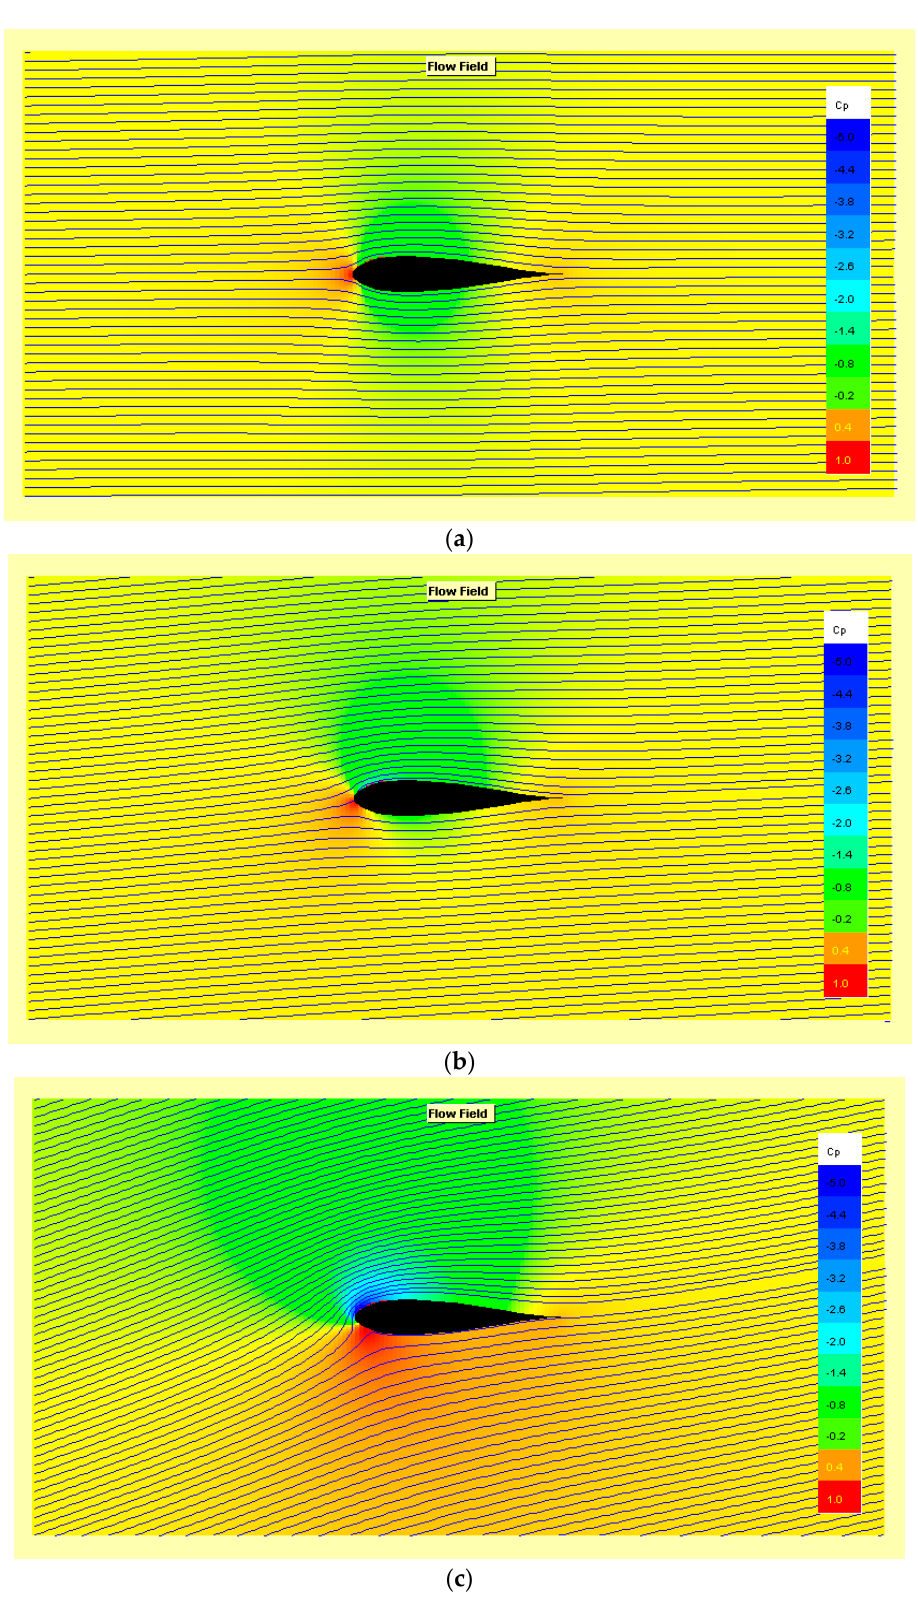
Figure 10. Flow field and pressure gradient of conditions (Speed = 0.52 kts, R e = 10 4 ) are shown at the following α att : ( a ) 0.5 ◦ ( b ) 4.0 ◦ ( c ) 15.0 ◦.